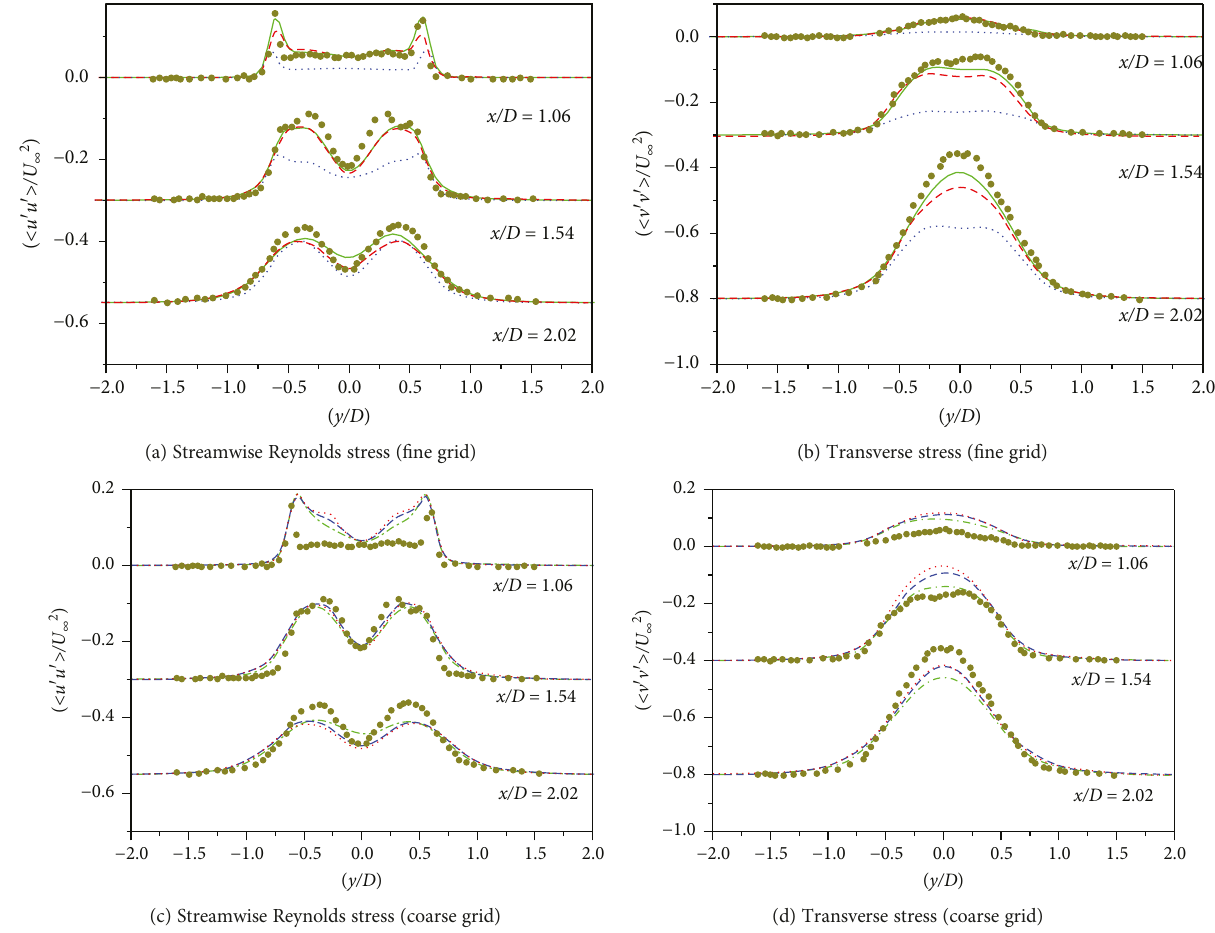
Figure 11: Mean Reynolds stress in di ff erent sections (for details, see the caption for Figure